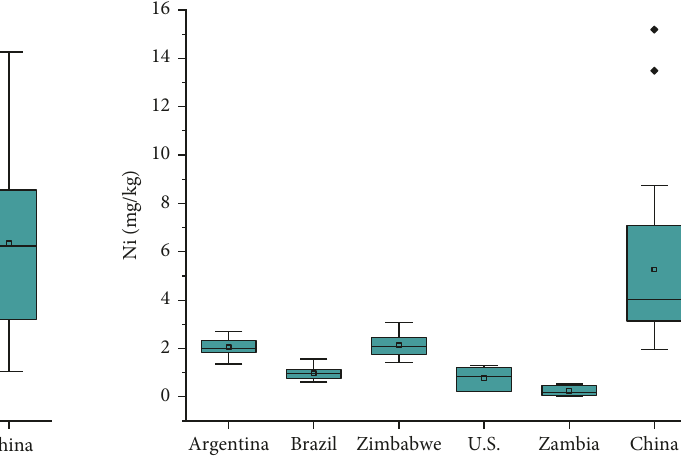
Figure 2: The box plots of Zn content in tobacco leaf from different countries in tobacco leaf from different countries.